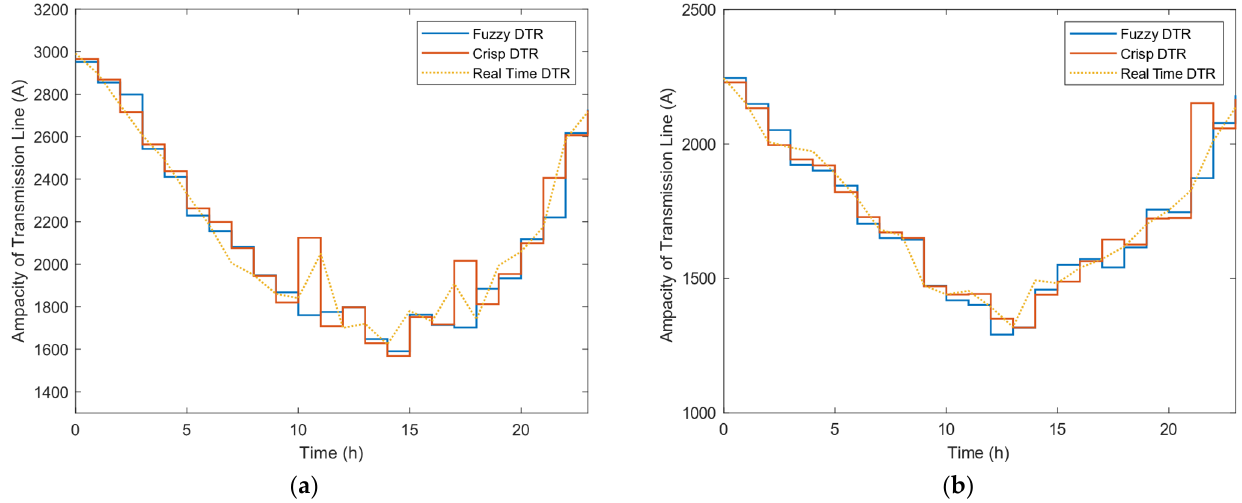
Figure 6. ( a ) Dynamic ratings of line for 24 h in winter; ( b ) dynamic ratings of line for 24 h in sum- mer.